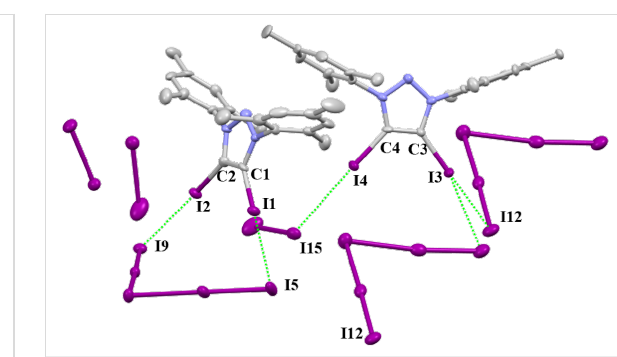
Figure 7: Packing structure of 2-I . 3.5I 2 . Hydrogen atoms have been omitted for clarity.